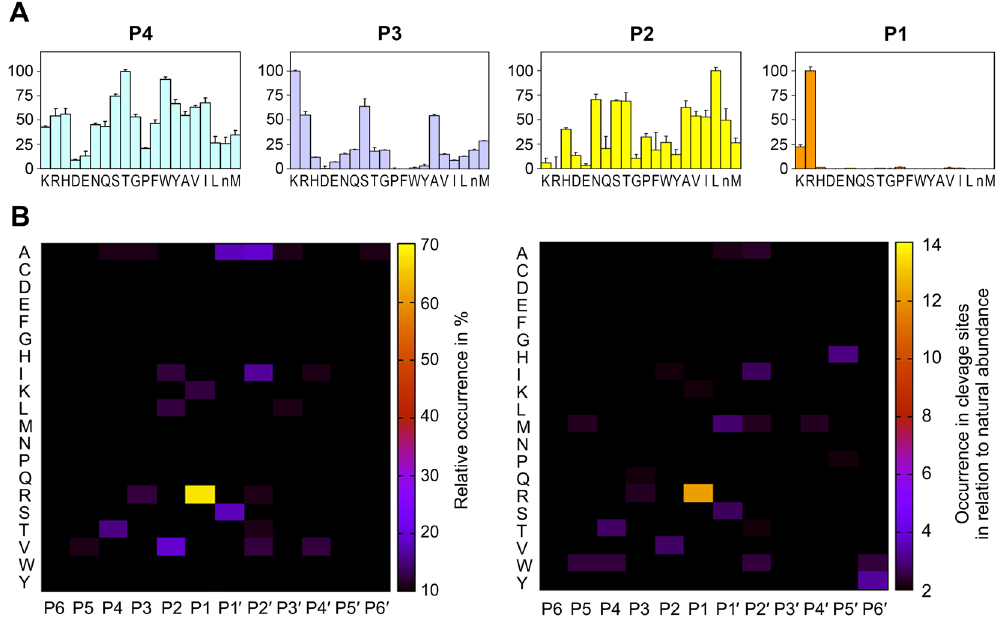
Figure 1. Specificity profiling with a positional scanning and proteomic identification of cleavage sites. ( A ) Peptide substrate specificity of KLK8 measured by positional scanning for peptide positions P4 to P1. The height of the columns represents substrate cleavage rates by released ACC, while the x-axis indicates the amino acids in one-letter code, whereby n represents norleucine, which substitutes Cys. ( B ) PICS heat maps with amino acids listed in alphabetical order along the y-axis and peptide positions run from P6 to P6 ′ on the x-axis. The left panel displays cleavages in 73 substrates and the right panel contains corrected values for the natural abundance of each residue. Both PICS and PSSCL agree in a moderate preference for Thr and Trp in P4 and for basic residues in P3, such as Lys or Arg. Aliphatic residues Leu, Val, and Ile are found by both methods in P2, whereby Val dominates in the corrected PICS, while PSSCL ranks the polar Asn, Ser, and Thr relatively high. The major primary specificity for Arg over Lys in P1 is found by both methods, albeit stronger in PICS. The corrected PICS data show a preference for Ser and Met in P1 ′ , for Ile and Trp in P2 ′ , and no distinct specificity for P3 ′ and P4 ′ . By contrast, S5 ′ and S6 ′ subsites are moderately specific for His and Tyr.